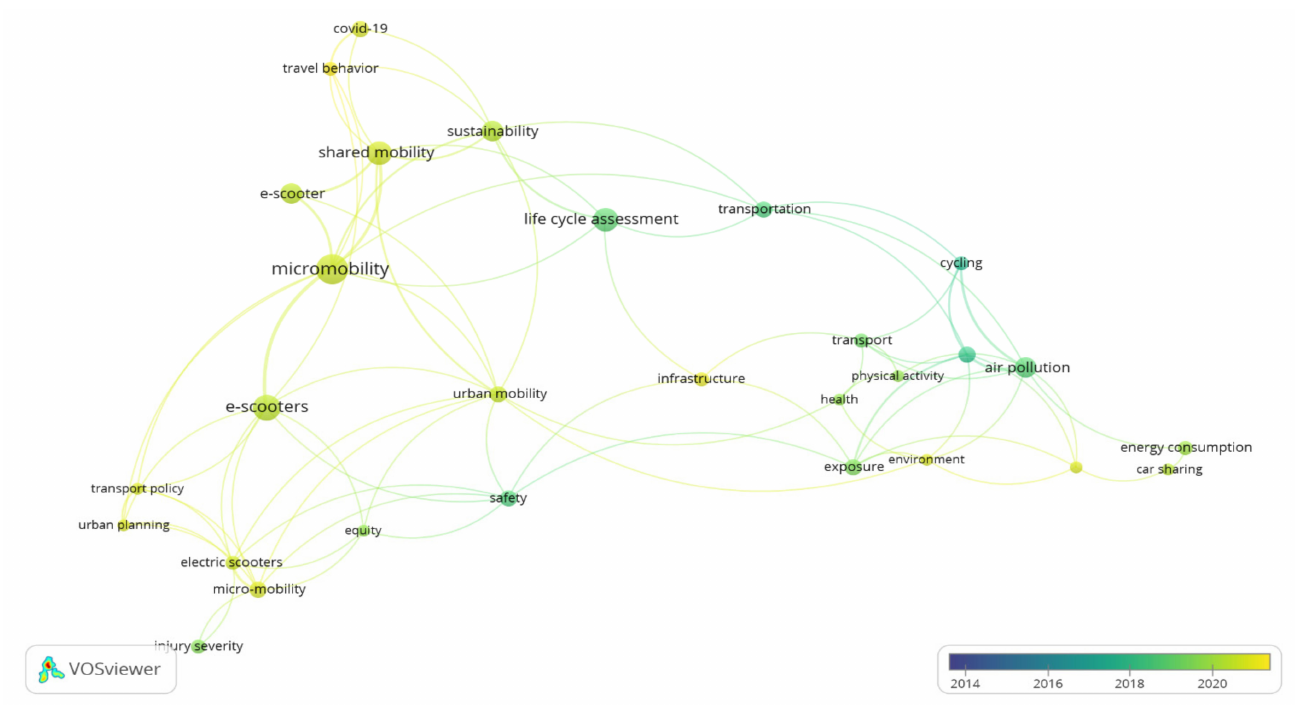
Figure 5. Visualization of the preponderance of each keyword considering co-occurrence and the publications’